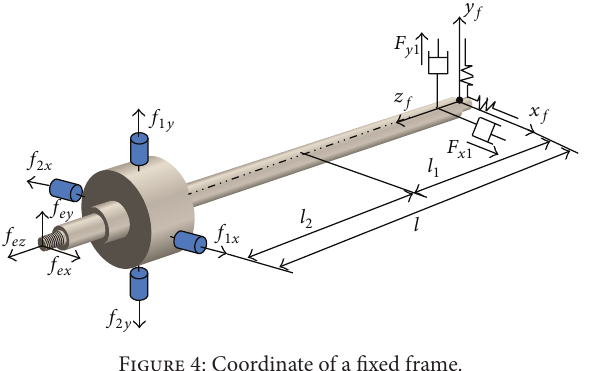
Figure 4: Coordinate of a fixed frame.